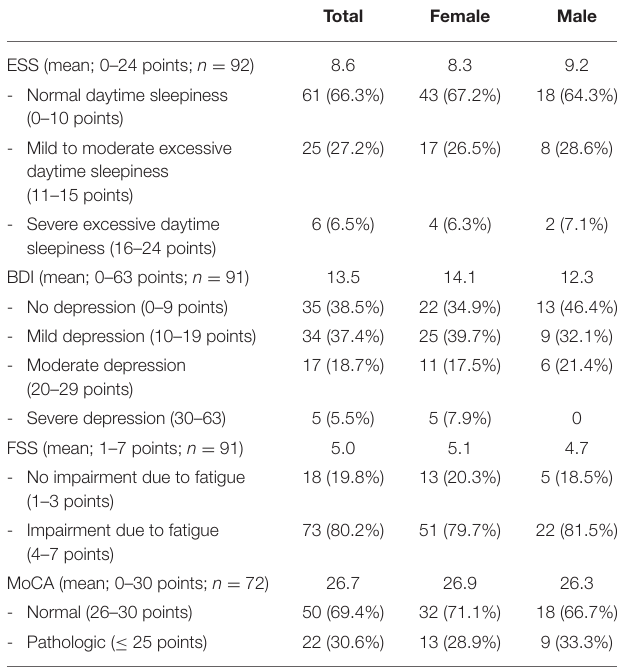
TABLE 2 | Evaluation of self-questionnaires and results of MoCA of patients presenting to the neurological post-COVID-19 outpatient